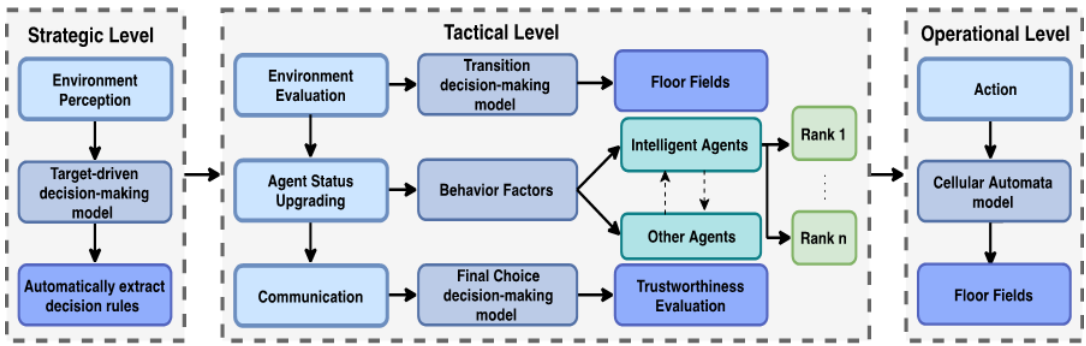
Figure 1. Multi-level multi-stage agent-based model (MLMS-ABM) system overview.